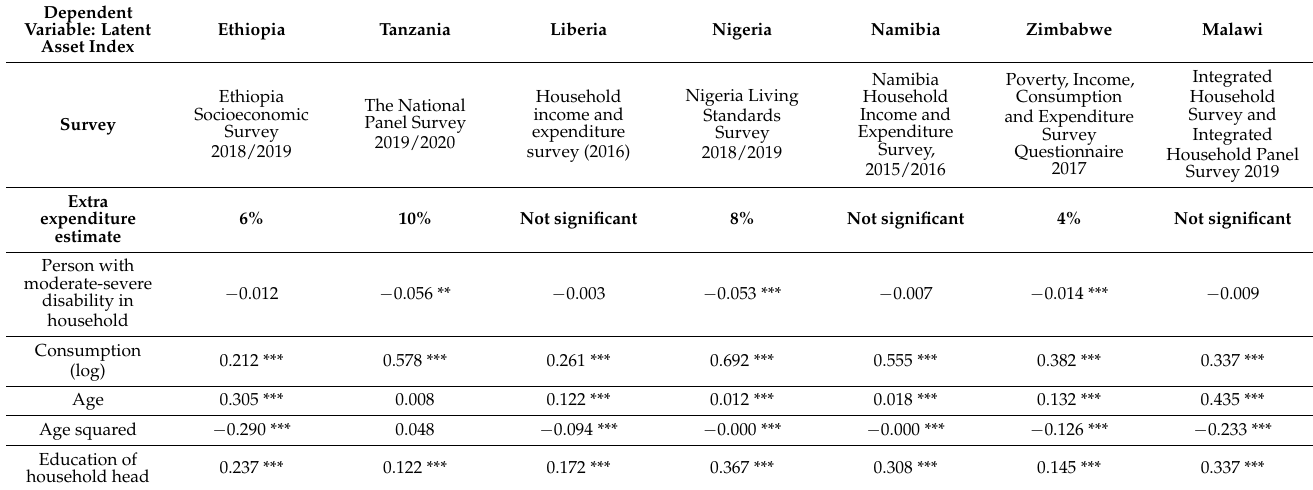
Table 2. Regression Results for